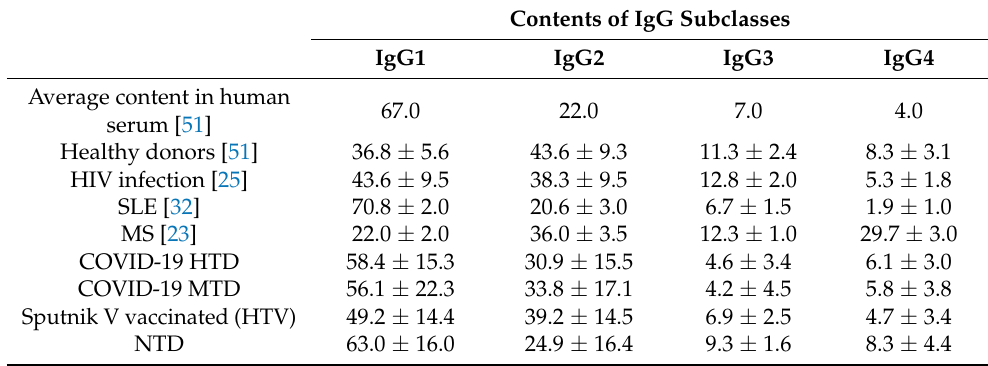
Table 2. Contents of IgG subclasses in the blood serum preparations and IgG